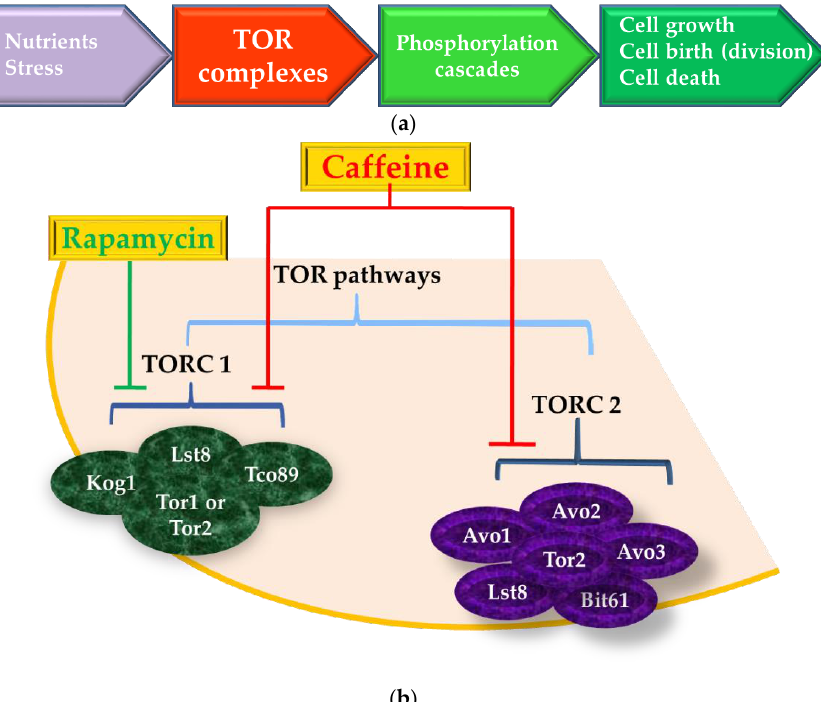
Figure 3. Schematic representation of target of rapamycin (TOR) complexes. ( a ) The main elements up- and downstream of TOR complexes. The TOR complexes are activated by nutrient status or by